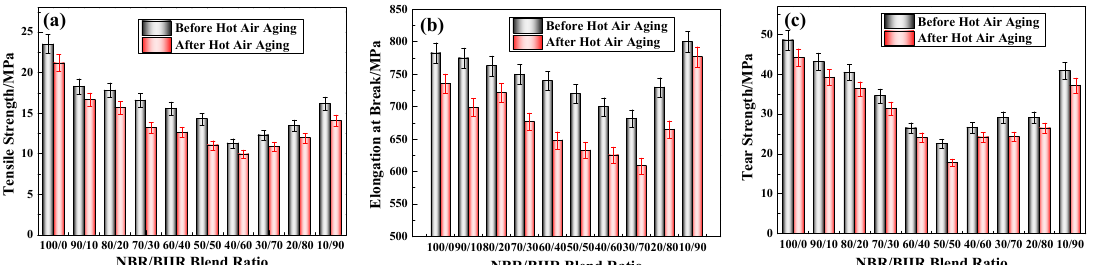
Figure 10 . Comparison of mechanical properties before and after aging of NBR/BIIR with various blend ratios: ( a ) Tensile strength; ( b ) elongation at break, and ( c ) tear strength. Table 4. Mechanical property parameters before and after aging of NBR / BIIR with various blend ratios. Tensile Strength / MPa Elongation at Break / % Tear Strength / kN / m NBR / BIIR Before and after Aging /% Before and after Aging /% Before and after Aging /% 100/0